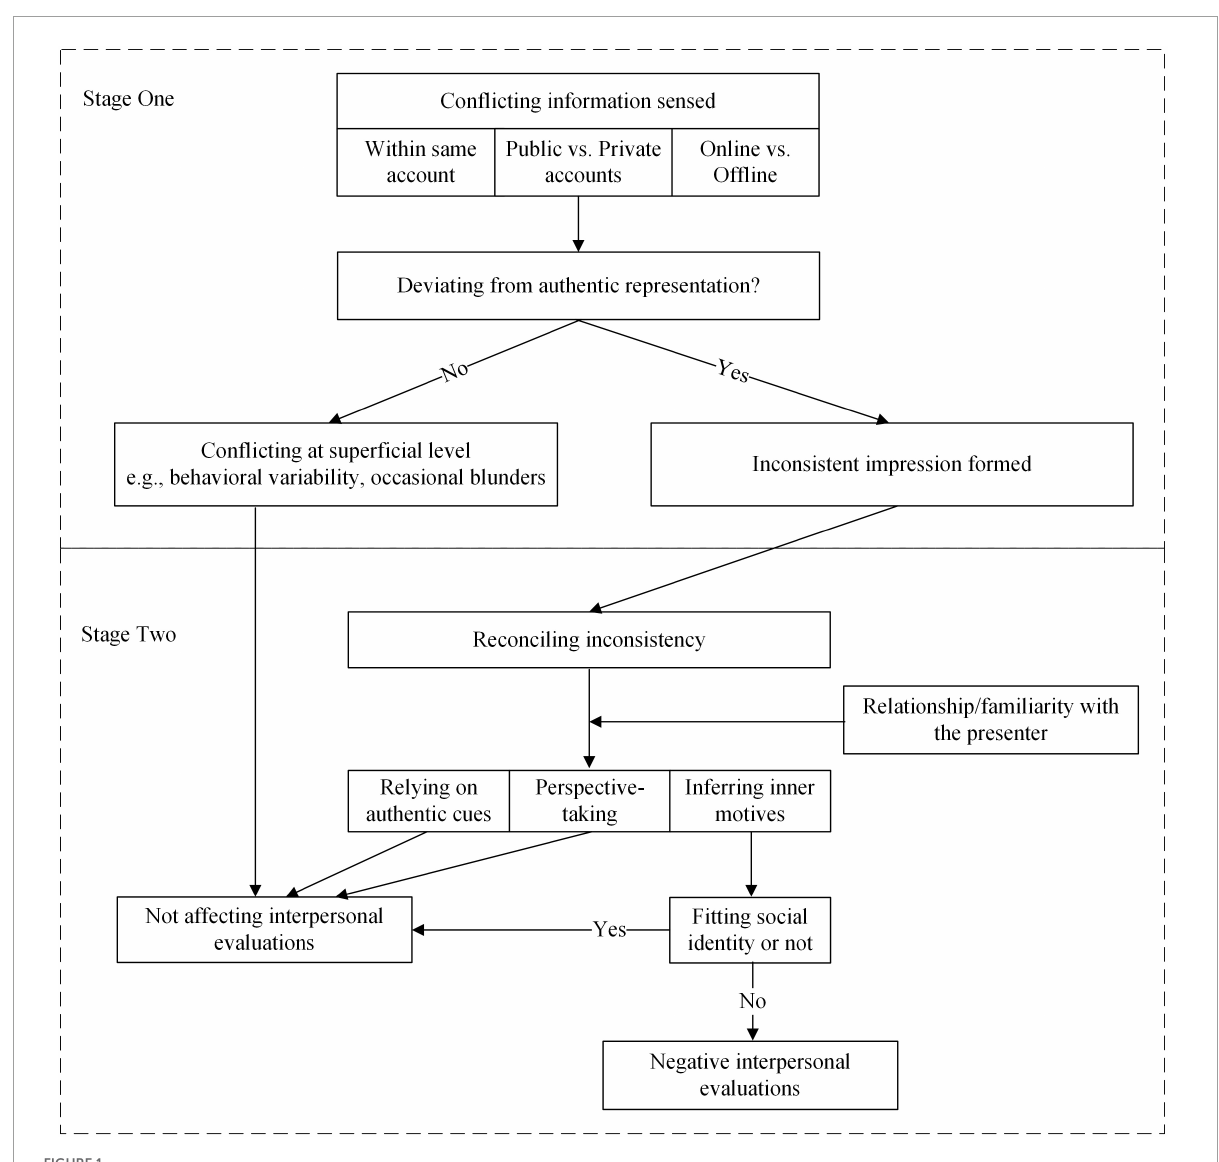
FIGURE1 A two-stage model of processing inconsistent information in